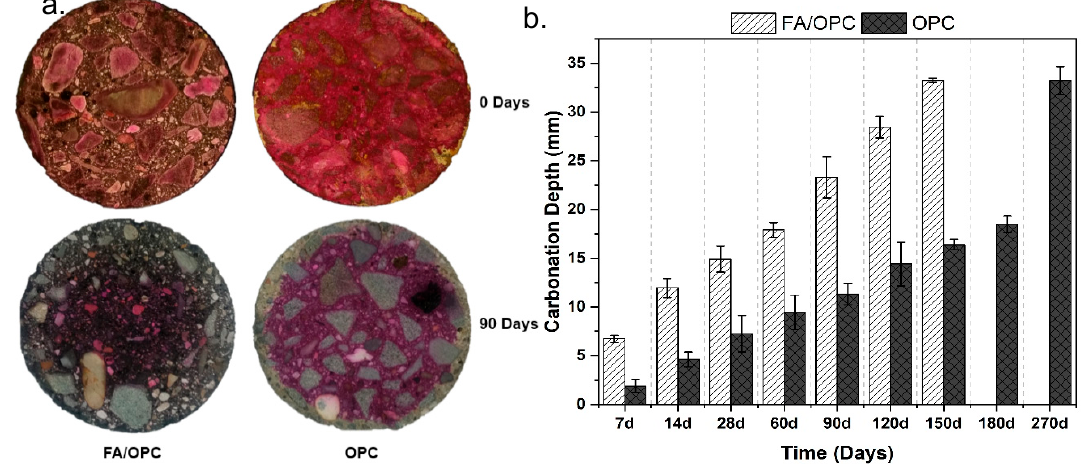
Figure 6. ( a ) Photographs of the concrete specimens at 90 days of exposure to CO 2 ; and ( b ) Carbonation depth.